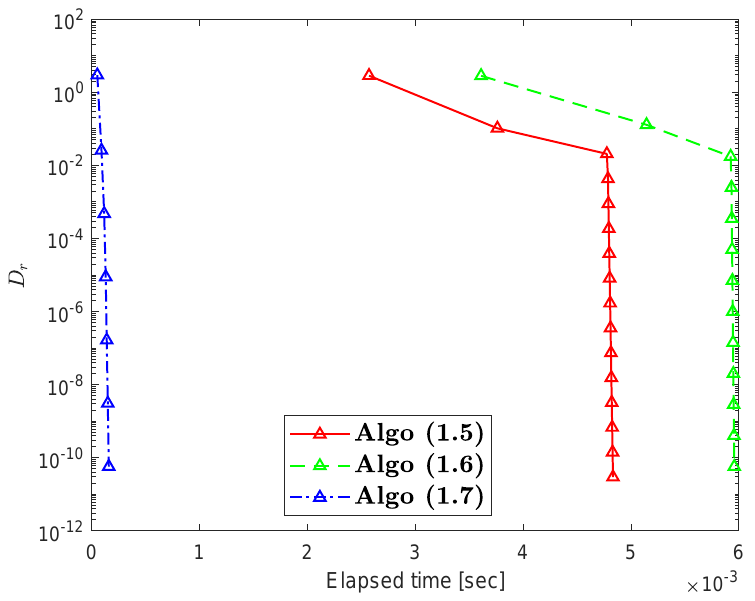
Figure 2. A graphical comparison of Algorithms (5)–(7), where z 1 = 3.00.